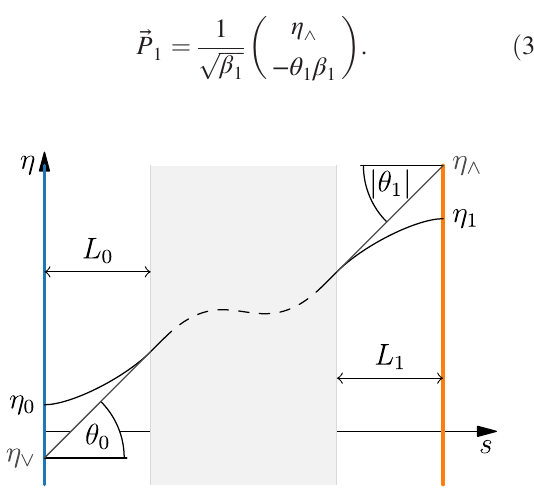
FIG. 11. Dispersion η 0 , η 1 and equivalent thin-dipole dispersion η η ∨ , ∧ for a half cell with unspecified interior and (compare to Fig.